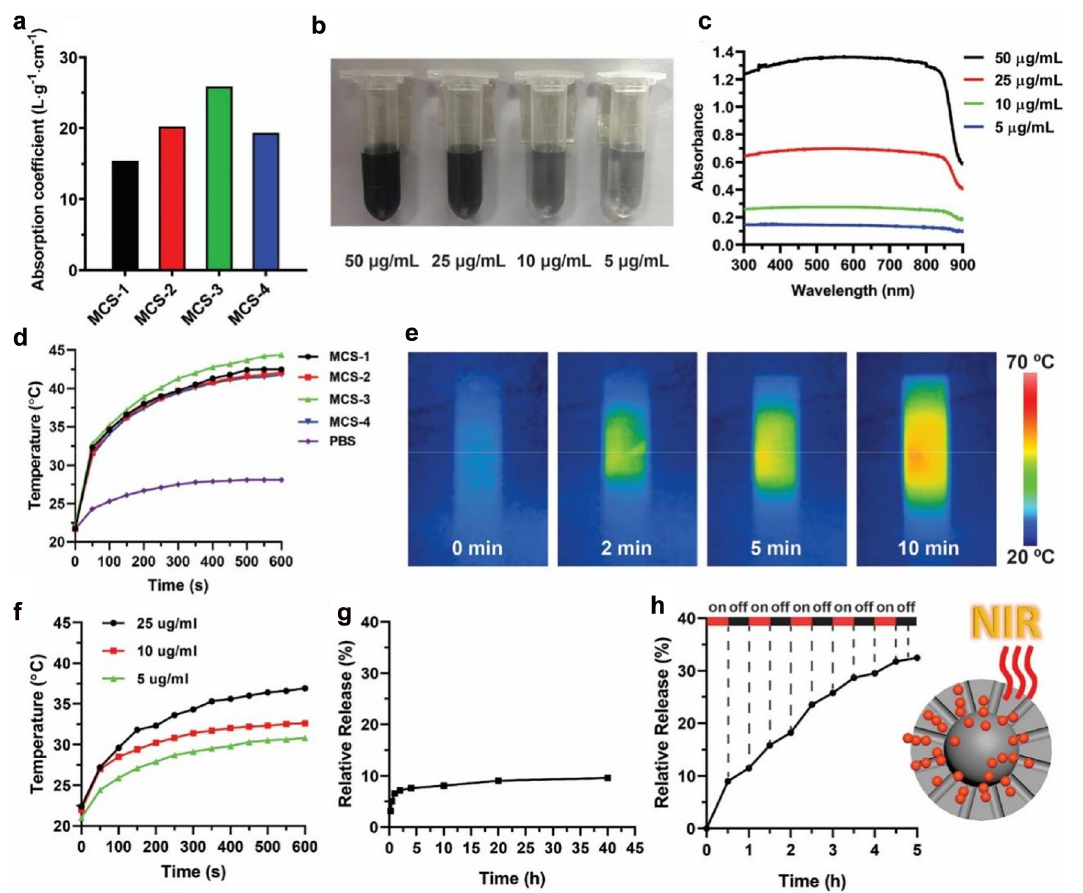
Figure 4: Calculated absorption coefficient for MCS-1, MCS-2, MCS-3, and MCS-4 (a). Solutions with various concentrations (b) and corresponding UV–Vis absorption spectra (c) for MCS-3. Photothermal effect of MCSs solutions (50 μ g/mL) upon an NIR irradiation at 808 nm with power density of 1 W cm − 2 (d). IR thermal images of MCS-3 solution upon NIR irradiation at 808 nm (e). Photothermal effect of MCS-3 solution upon NIR irradiation at 808 nm (1 W cm − 2 ) at different concentrations (f). Free diffusion release of DOX from MCS-3 (g). Cumulative release profiles of NIR irradiation induced DOX release from MCS-3